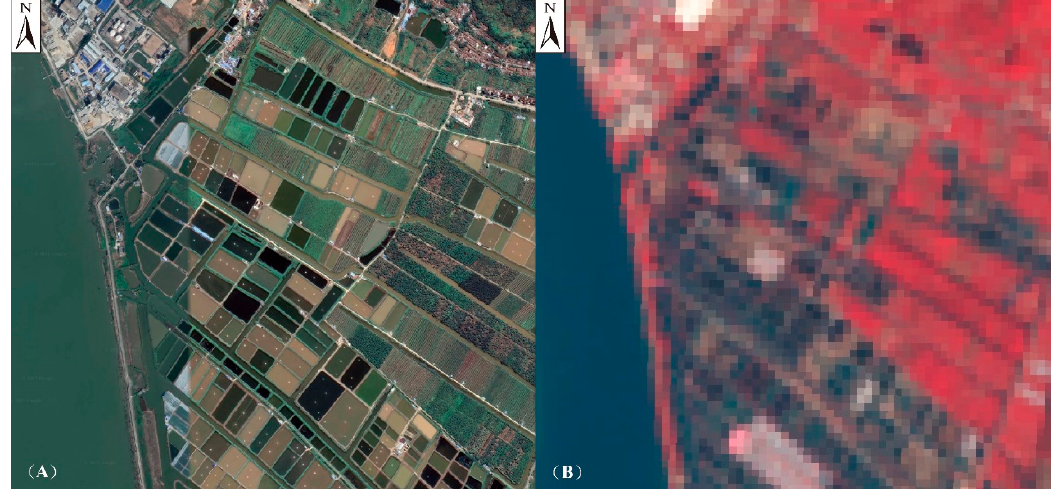
Figure 14. Fish ponds in Google Earth high resolution image ( A ) and Landsat image ( B ). Table 2. Error Matrix of Classification Accuracy Assessment for Each Yearly